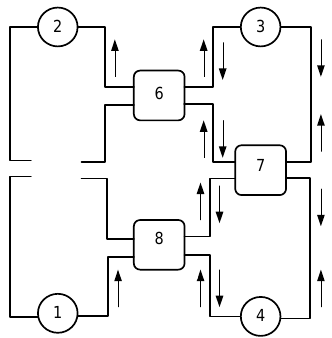
Figure 5. Frame distribution under the standard HSR protocol as a result of sending a unicast frame from Node 1 to Node 2 under a Node 5